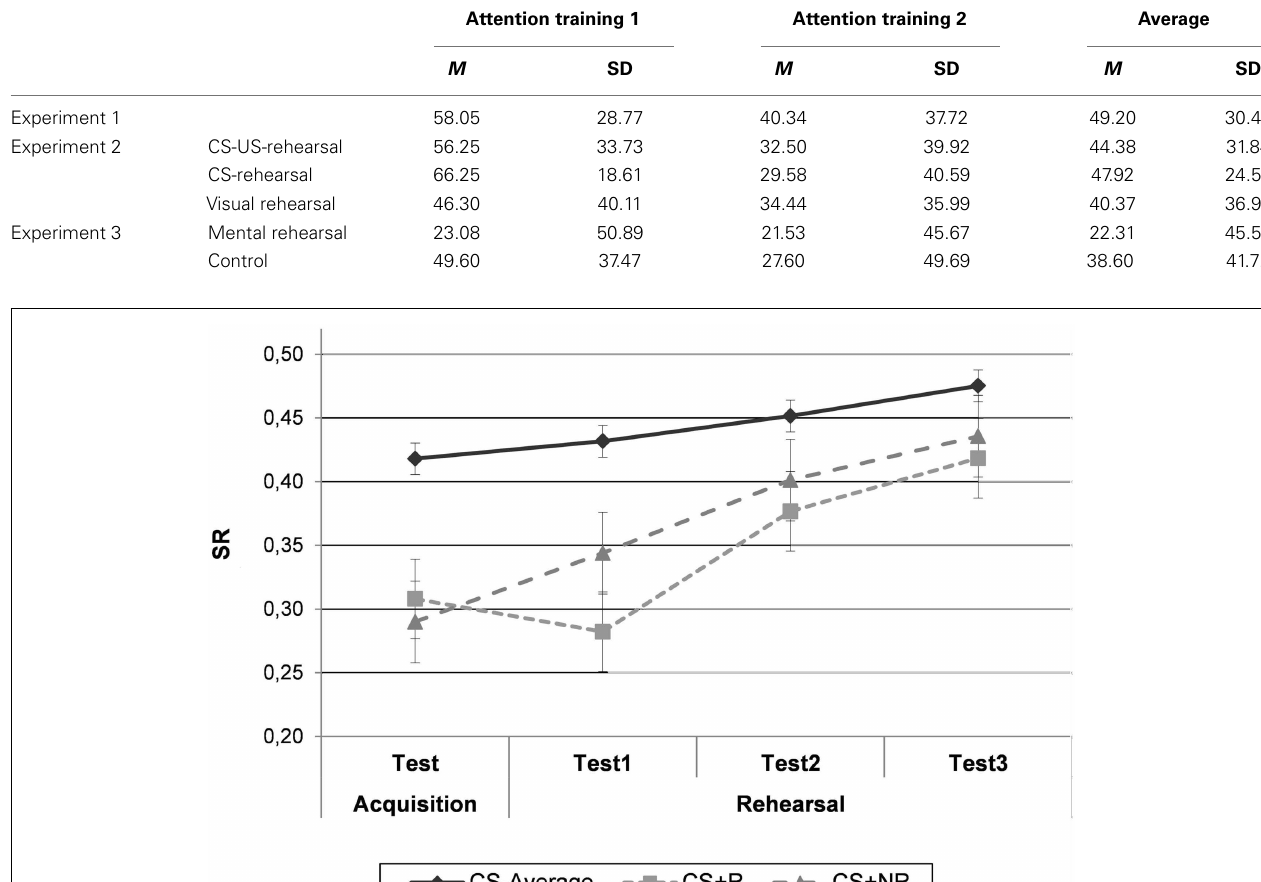
Table 1 | Mean attention score (and standard deviations) on the first and the second attention training task and average for both tasks, as a function of experimental group for Experiments 1, 2, and 3.